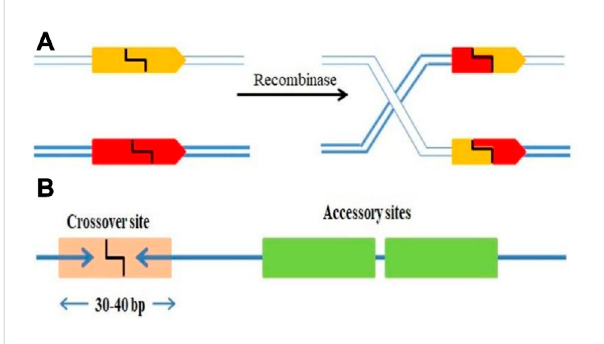
FIGURE 1 (A) SSRs facilitating DNA strand breakage at two points (pointed boxes) followed by rearranging ( “ swap ” ) the broken ends and reconnectingthem inthenew con fi guration. (B) A crossover site(light orange box) with inverted repeat symmetry (two blue arrows) binding an SSR dimer and containing the broken bonds and re-joined by the SSR at its centre (typically 30 – 40 bp). The crossover site could have accessory sites (Green boxes) that bind more SSR and/or regulatory protein subunits.